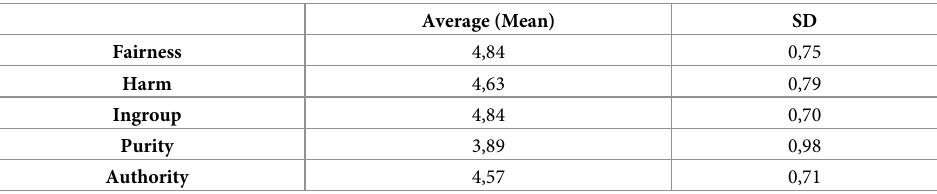
Table 2. Means and standard deviations from MFQ